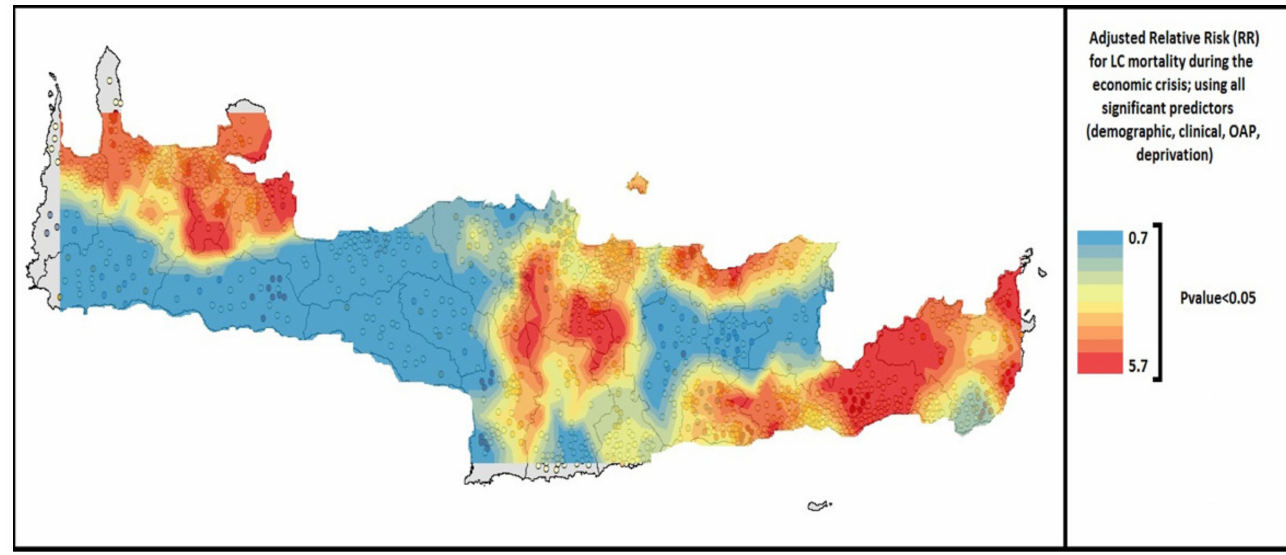
Figure 4. Lung cancer Relative Risk (RR) for mortality using all significant predictors